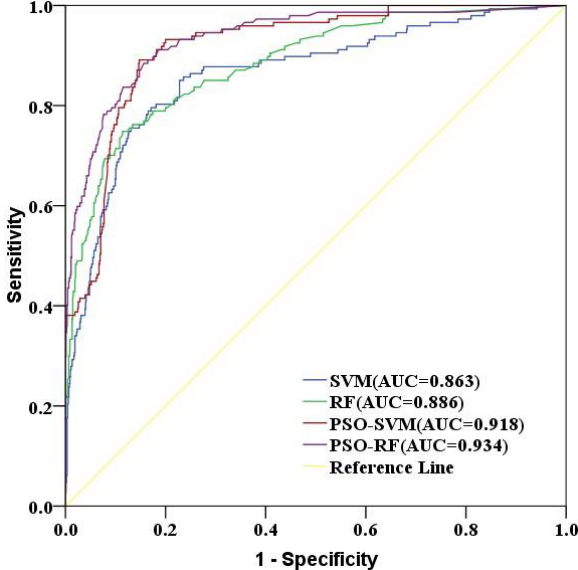
Figure 5. Receiver operating characteristics (ROC) curves and area under the curve (AUC) values of testing dataset for the PSO-RF, RF, PSO-SVM, and SVM models.